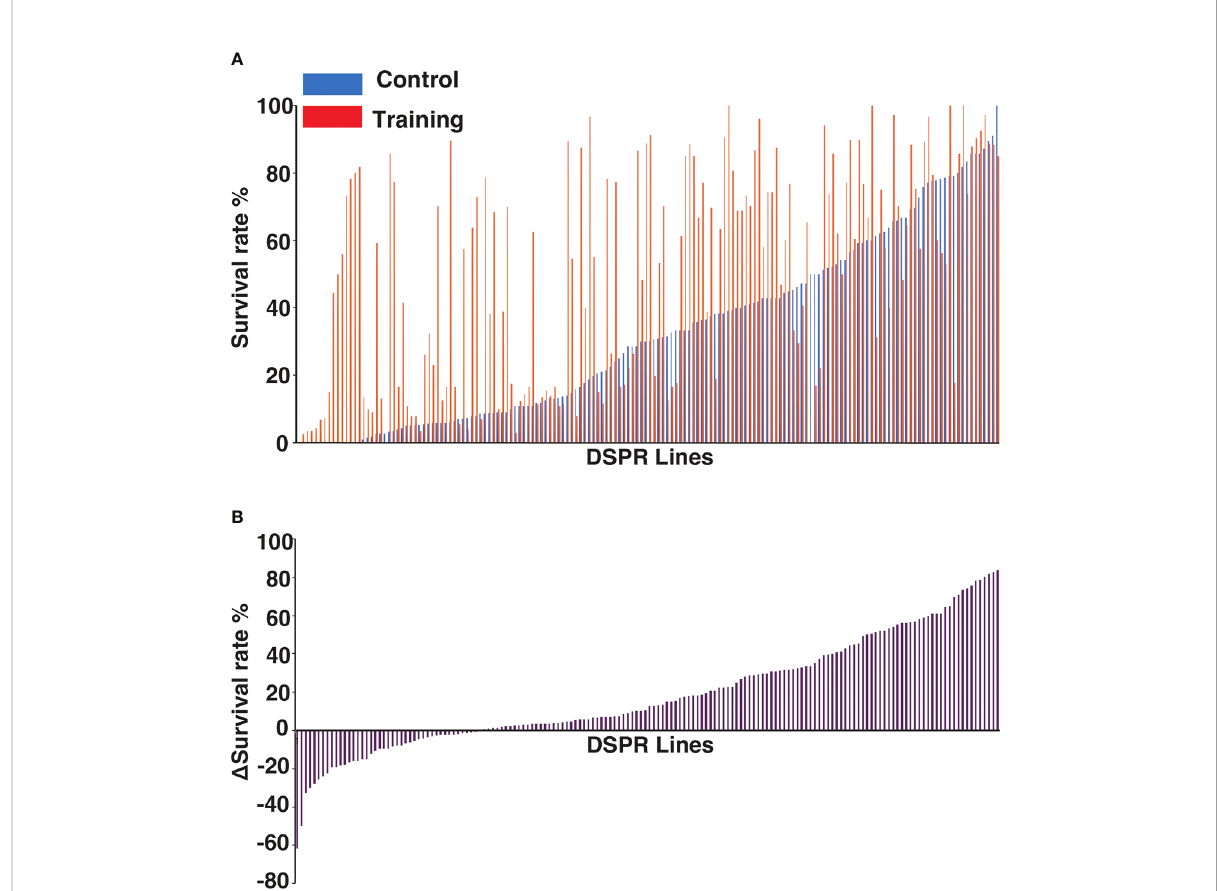
FIGURE 3 Genetic variations in training effects across DSPR lines. (A) Survival rates of 163 DSPR lines on day 3 after challenge under control and training conditions. DSPR lines are ordered according to their survival rates under control conditions. The survival rates of each line are represented by blue (control conditions), and red (training conditions) bars aligned side by side. (B) Variations in D survival rates (training effects) across 163 DSPR lines on day 3 after Sa challenge. DSPR lines are ordered according to D survival rates, which differ from (A) . Raw data are shown in Supplementary Data